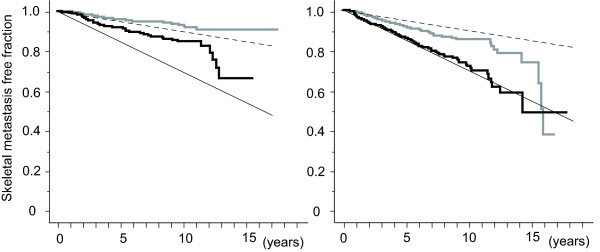
Bone Metastasis Free Fraction Curves of Stage II Breast Cancer Patients. Bone metastasis free fractions are shown for stage II breast cancer patients with medium (left) and high risk histology (right). Grey stair-like line indicates stage IIA and black stair-like line indicates stage IIB. Oblique straight lines indicate 3% per person-year (solid) and 1% per person-year (dotted) lines.